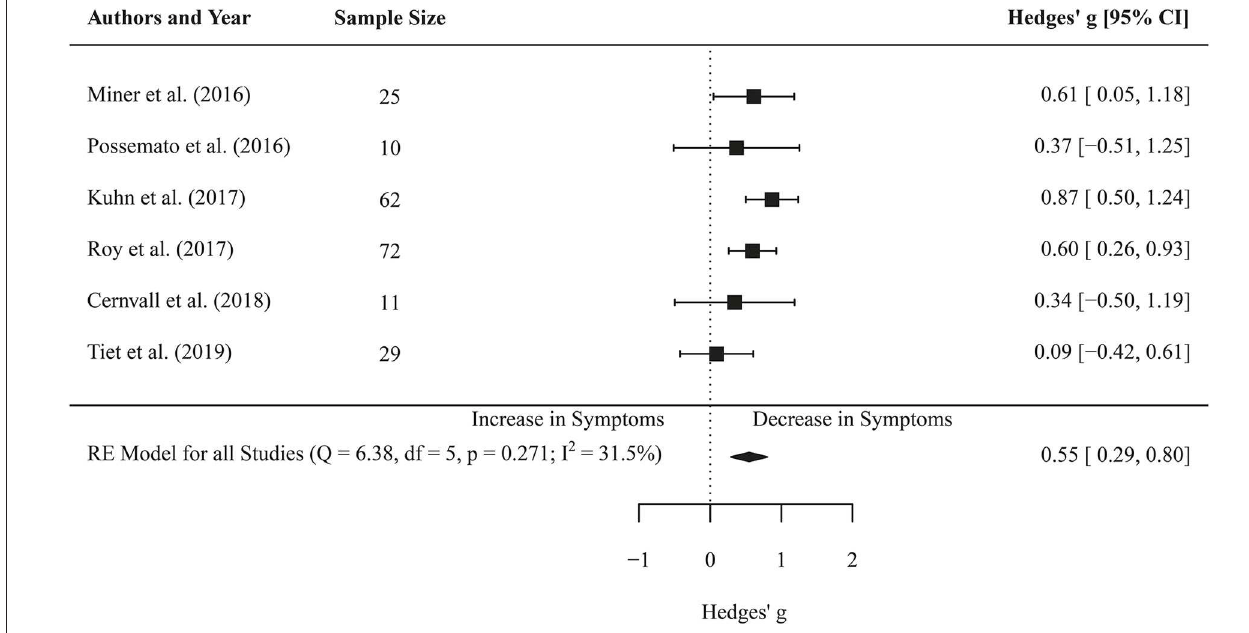
FIGURE 3 | Forest plot of the standardized mean difference (Hedges’ g ) of the effect of self-management smartphone-based apps on depressive symptoms (pre-post changes). A positive effect size indicates that the depressive symptoms decreased at the post measurement.